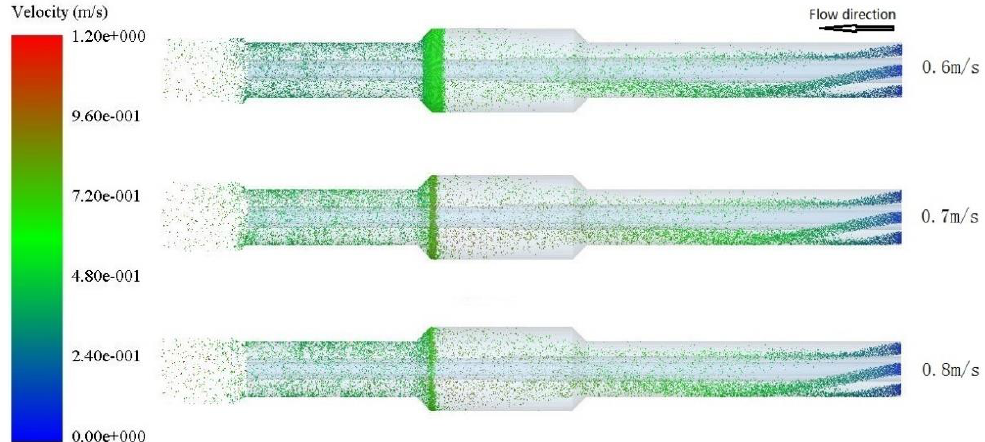
Figure 5. Particle distribution map after 10 s simulation time with different velocity under 45-degree angle expansion.